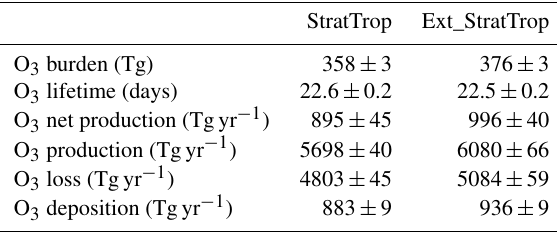
Table 3. Comparison of tropospheric O 3 burden and budget terms during 2004–2014 simulated with StratTrop and Ext_StratTrop chemistry schemes in UKCA. One standard deviation in the an- nual terms over the 2004–2014 period is shown. We define the tropopause based on the highest layer with an O 3 mixing ratio of less than